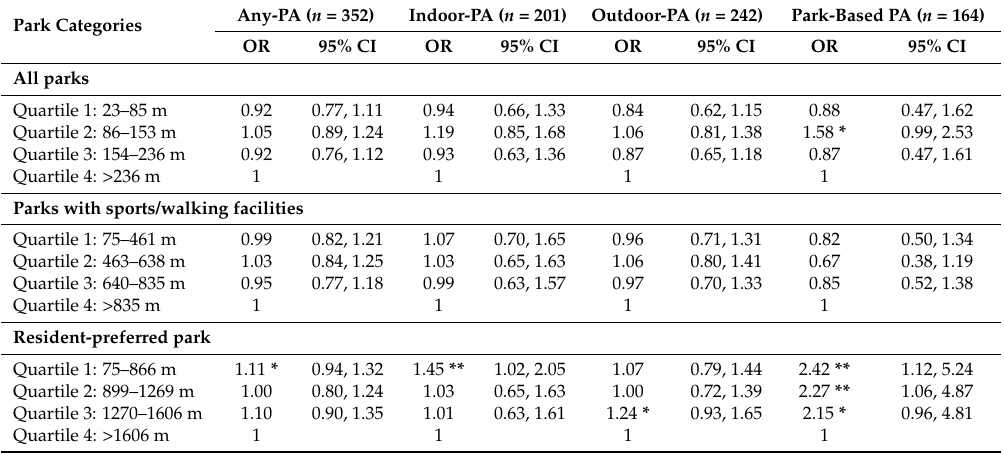
Table 4. Adjusted independent odds ratios between proximity to parks and physical activity (PA) a . Park Categories